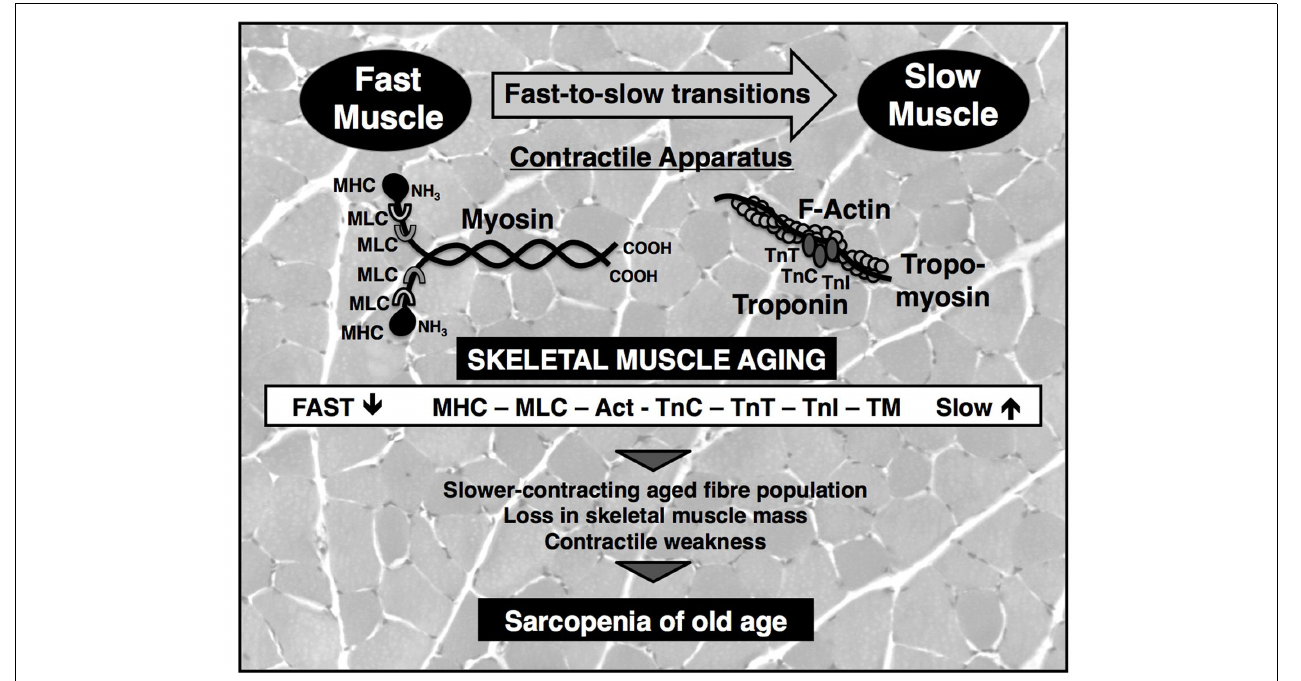
actin (Act), and tropomyosin (TM), as well as troponin subunits (TnC,TnT,TnI). Besides the slowing of contractile force, the progressive loss of muscle mass and resulting contractile weakness are the main cause of sarcopenia of old age.The background shows a transverse section of gastrocnemius muscle stained with hematoxylin and